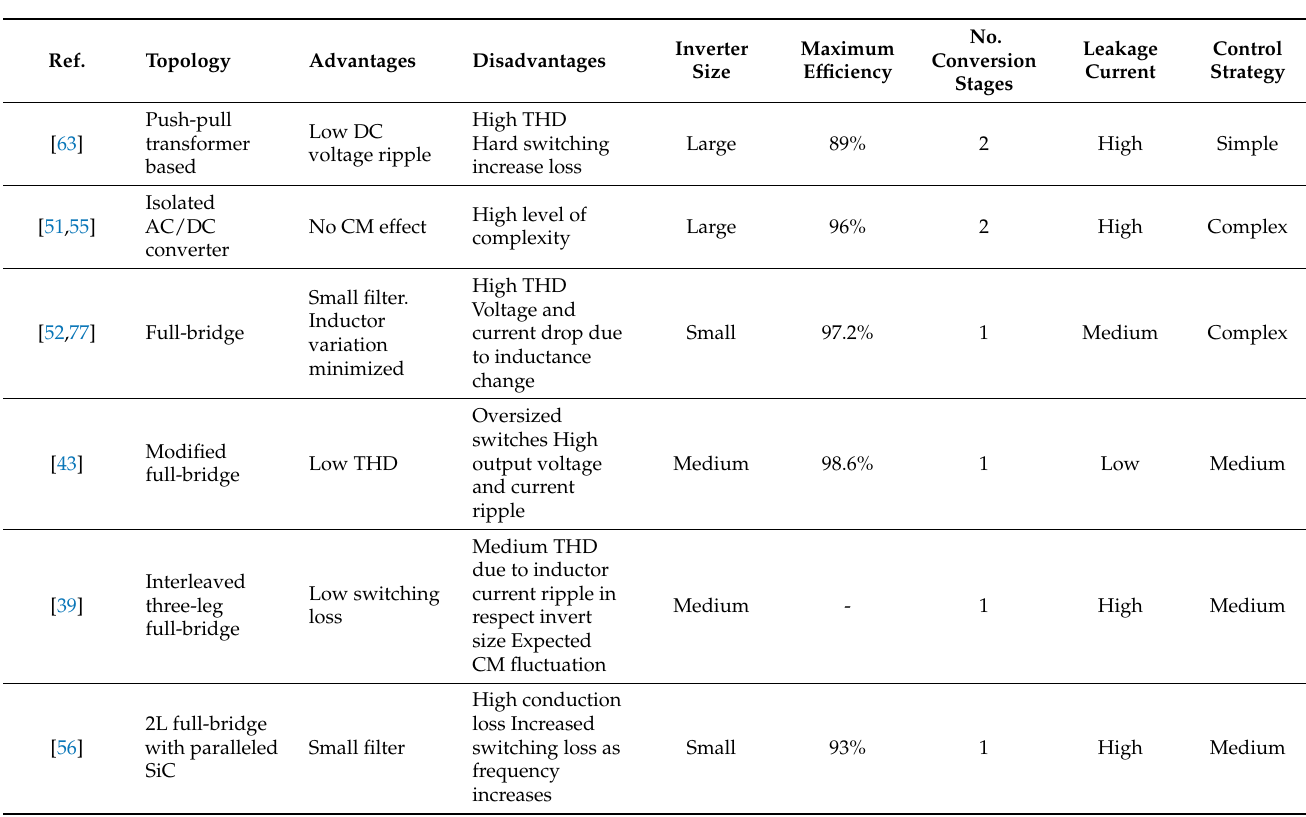
Table 3. Main comparison summary of bidirectional single-phase inverters for integration with DC distribution